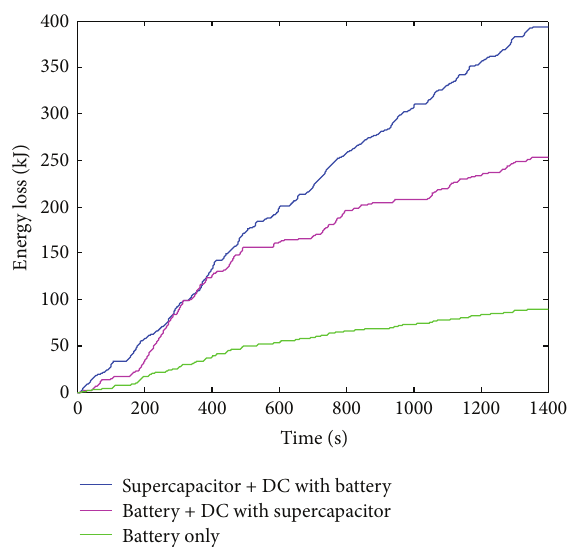
Figure 32: Energy loss comparisons of two semiactive topological structures and battery only system for UDDS driving cycle.